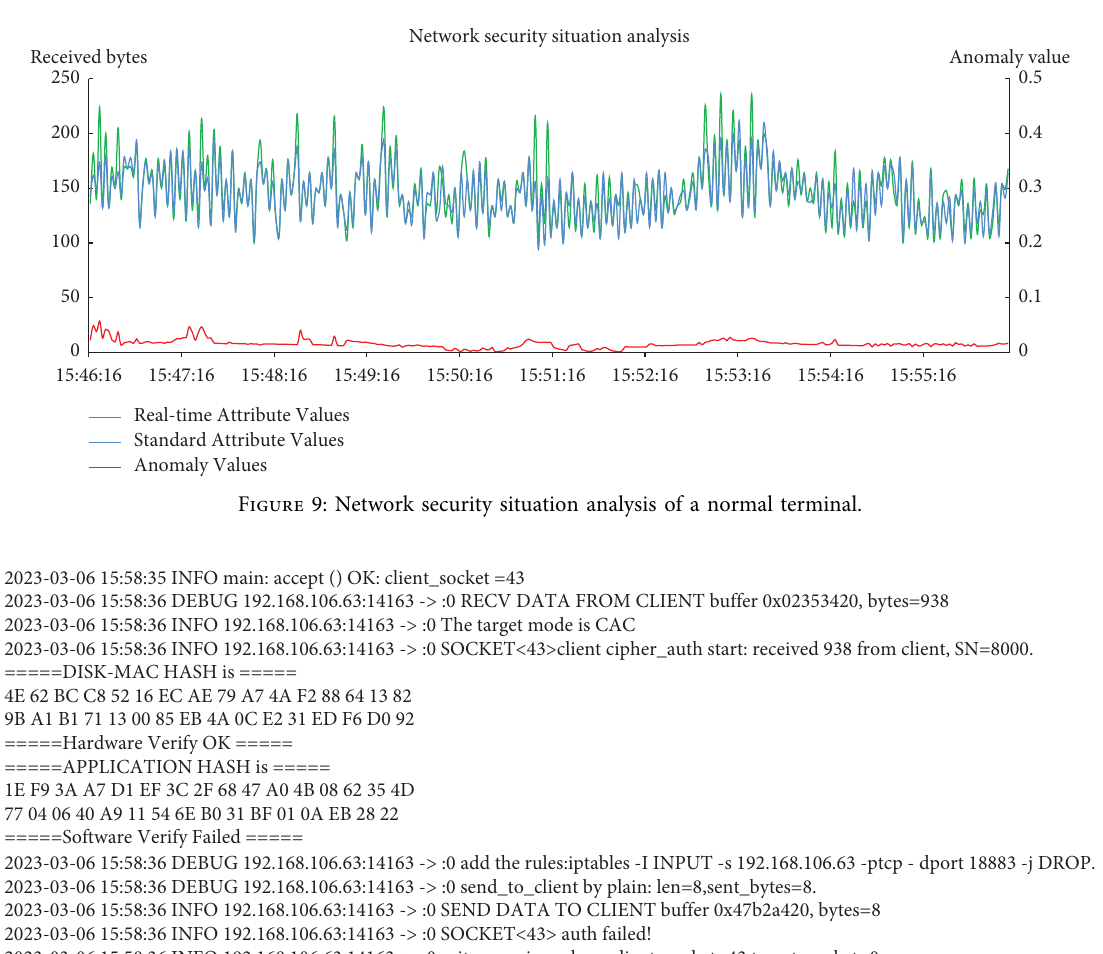
Figure 10: Simulation of the test process of the abnormal terminal.